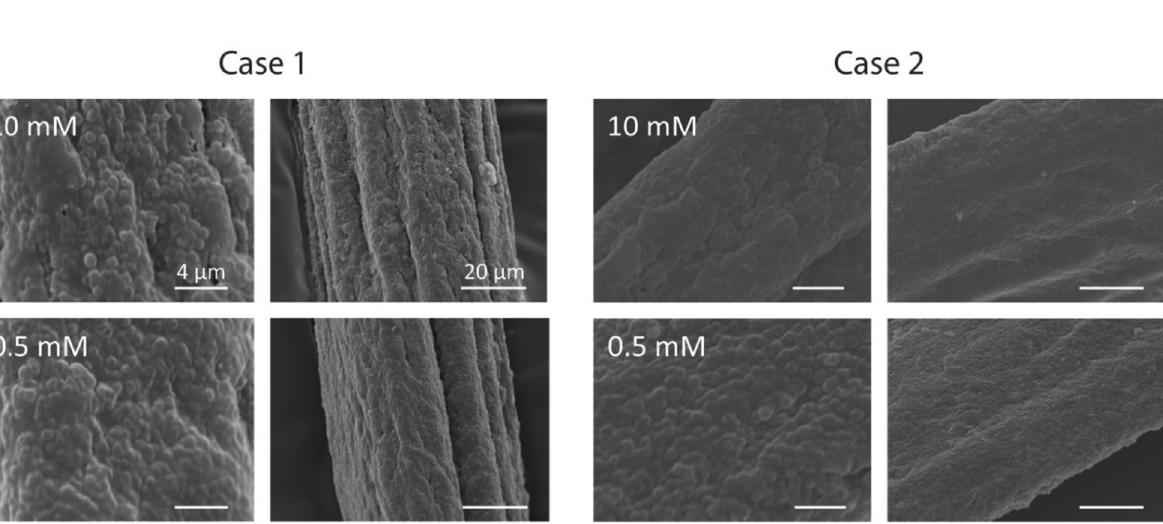
Figure 3. SEM images of the byssus surface. Case 1: Zn 2+ treated sample at pH 7 where no difference was observed between the two concentrations examined, 10 mM and 0.5 mM. This image is representative of the surface morphology effect of Cd 2+ , Ni 2+ , V 3+ , and Zn 2+ at pH 7 and for all metals studied at pH 4. Case 2: Mn 2+ at pH 7 where the 10 mM solution treated sample showed a smoother surface than those treated with the 0.5 mM solution. This image is representative of the surface morphology effect of Co 2+ , Cu 2+ , Fe 3+ , and Mn 2+ at pH 7. For each condition, two different magnifications are